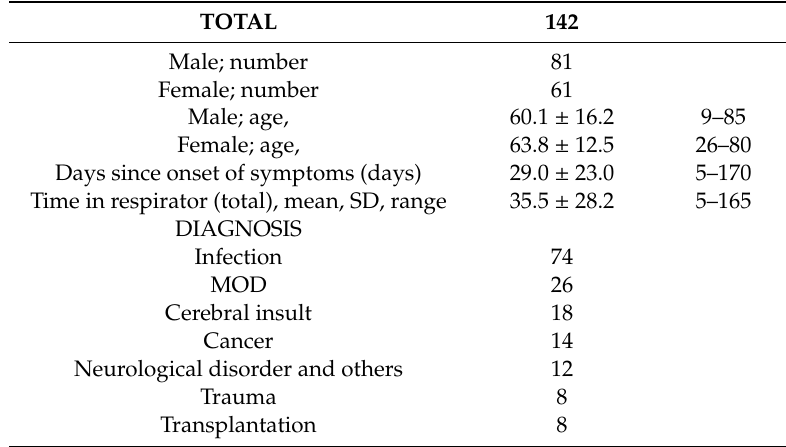
Table 1. The spectrum of main clinical diagnoses are presented for the 142 ICU patients. Two patients were not included in this table since they were excluded because of very high age which may impact on the myosin:actin (M:A) ratio. It should be observed that some patients were su ff ering from multiple diagnoses. Values are given as ranges and means ±